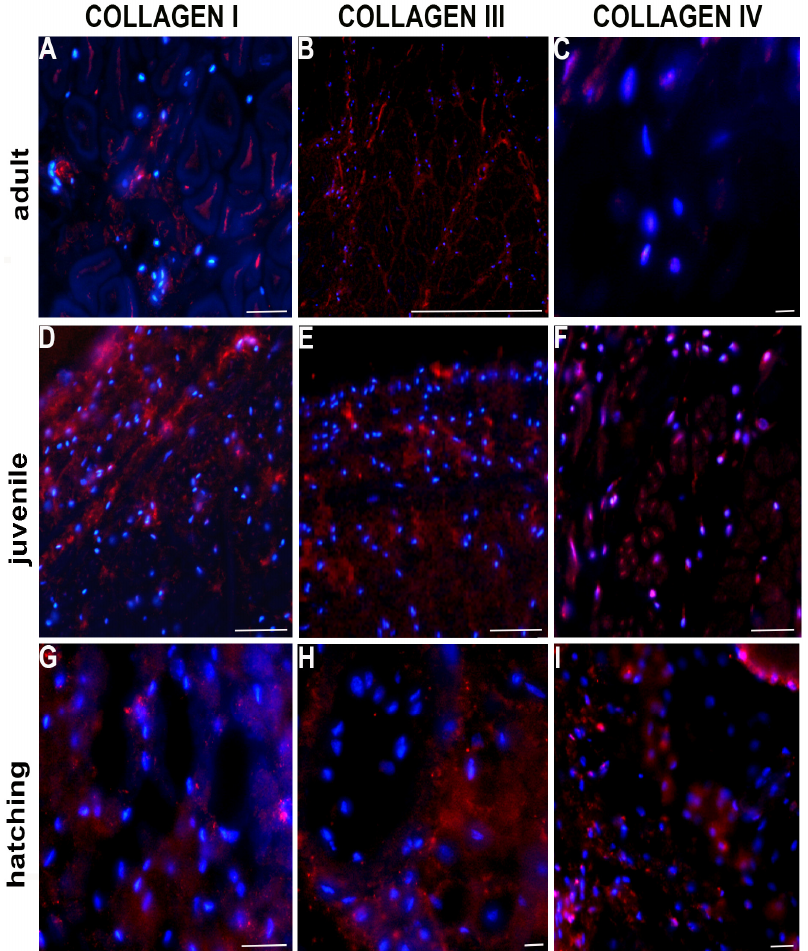
Figure 5. Immuno-characterization of collagen in cross sectioned adult, juvenile and recently hatched H. verbana. Immunofluorescent analyses show many cells positively reacting with collagen I ( A , D , G ), III ( B , E , H ), and IV ( C , F , I ) antibodies (in red). The expression of collagen, in general, is higher in hatching ( G – I ) and juvenile leeches ( D – F ) and decreased in the adult ( A – C ). Nuclei are counterstained with DAPI (in blue). Scale bars: ( A – I ) 30 µ